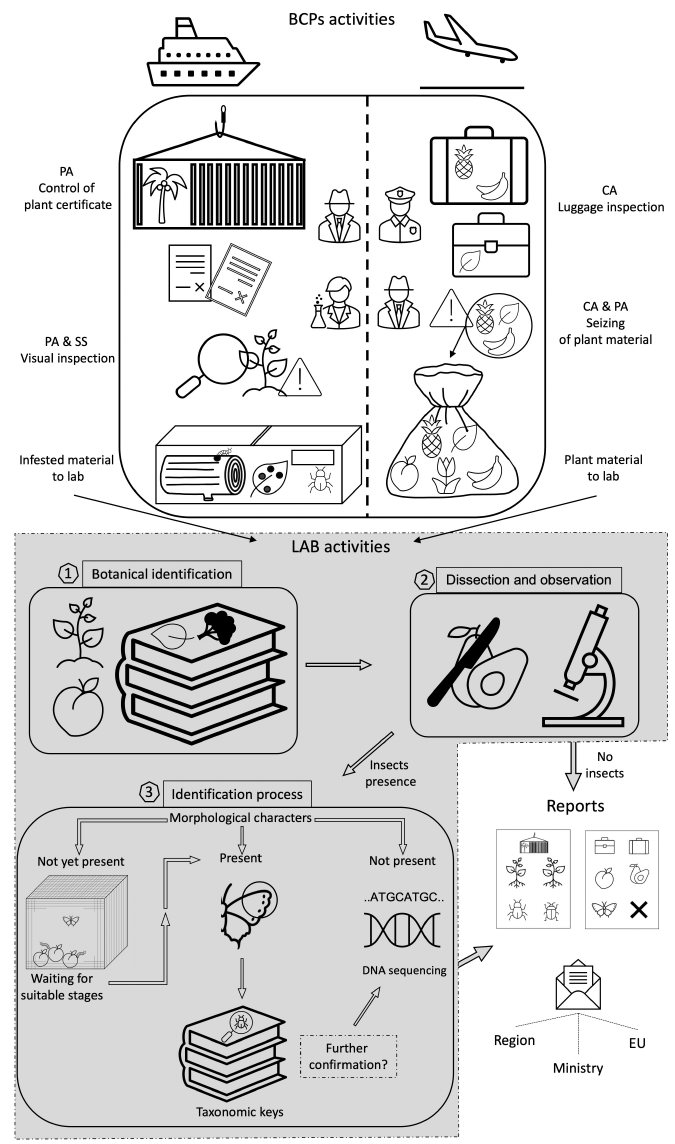
Figure 1. Summary workflow for BCPs and lab activities aimed at intercepting and identifying infested plant materials and pests. PA, phytosanitary agent; CA, customs authority; SS, scientific